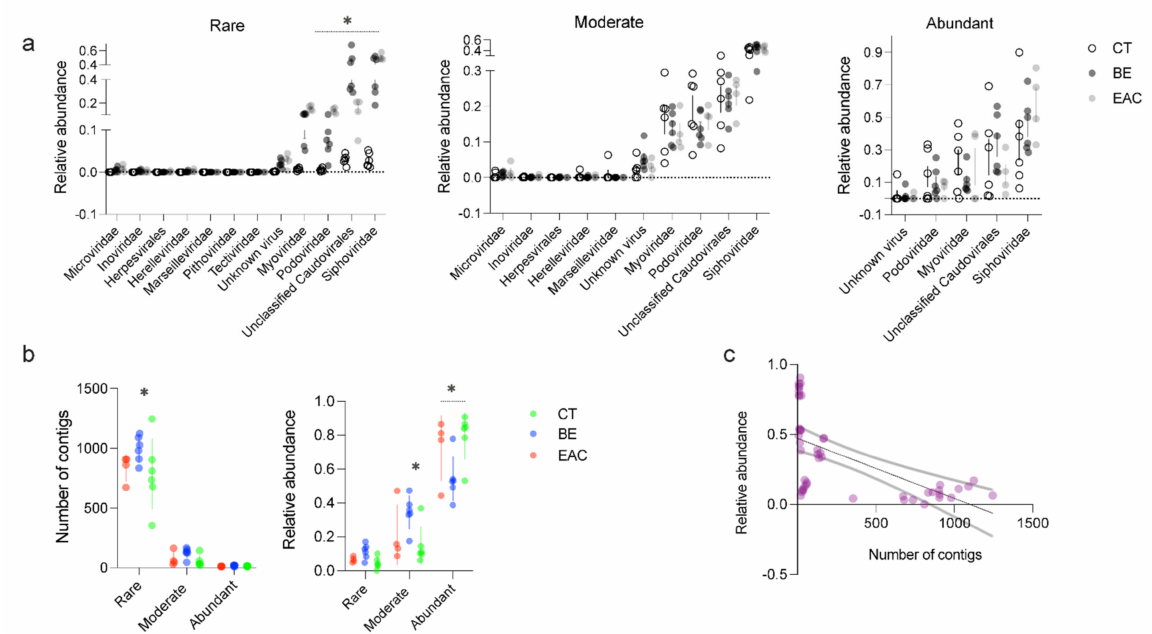
Figure 2. Composition of the rare, moderate, and abundant gut viruses in CT, BE and EAC samples. Rare, moderate, and abundant viruses were categorized based on the viral contig level. Abundant viruses represent viral contigs whose relative abundance was more than 1% in total contigs, moderate viruses represent viral contigs whose relative abundance was more than 0.1% and less than 1% in total contigs, and rare viruses represent viral contigs whose relative abundance was less than 0.1% in total contigs. ( a ) The relative abundance of viral families; ( b ) Number of contigs generated each viral contig category, rare, moderate, and abundant, on left and relative abundance of them on right. ( c ) Negative correlation between number of contigs, from rare, moderate, and abundant phages, and their relative abundance. CT represents stool samples from healthy controls; BE represents stool samples from Barrett Esophagus patients; EAC represents stool samples from Esophageal Adenocarcinoma patients. Statistical significance was determined by two–way analysis of variance [ANOVA], Tukey’s post hoc test, asterisk indicates p <